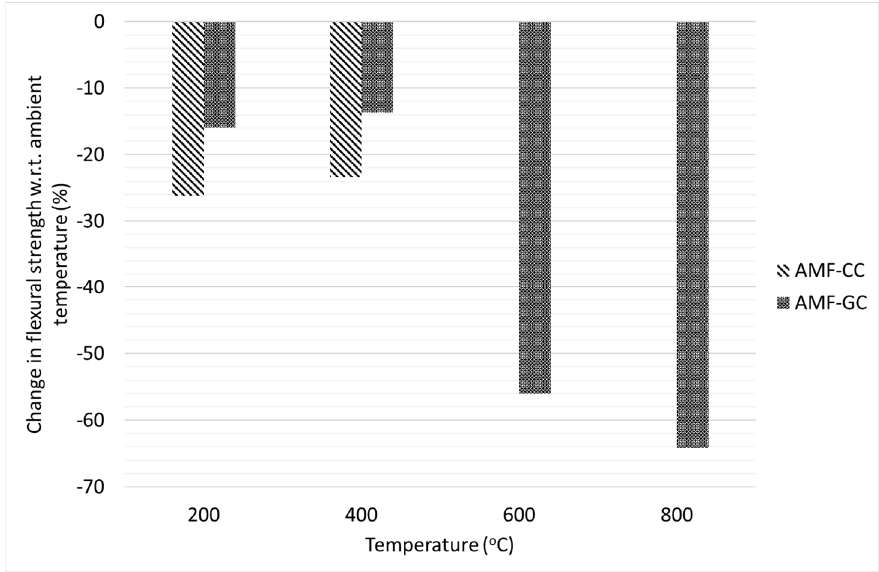
Figure 10. Change in fl exural strength of AMF reinforced cement and geopolymer concrete at elevated temperature.